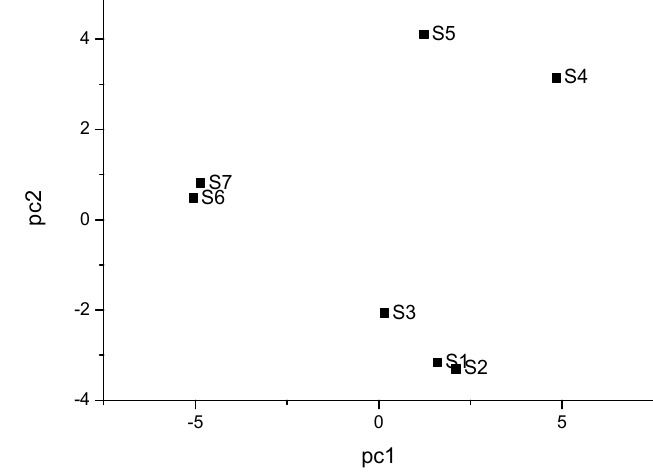
Figure 5. PCA score plots of the seven pepper oil samples.